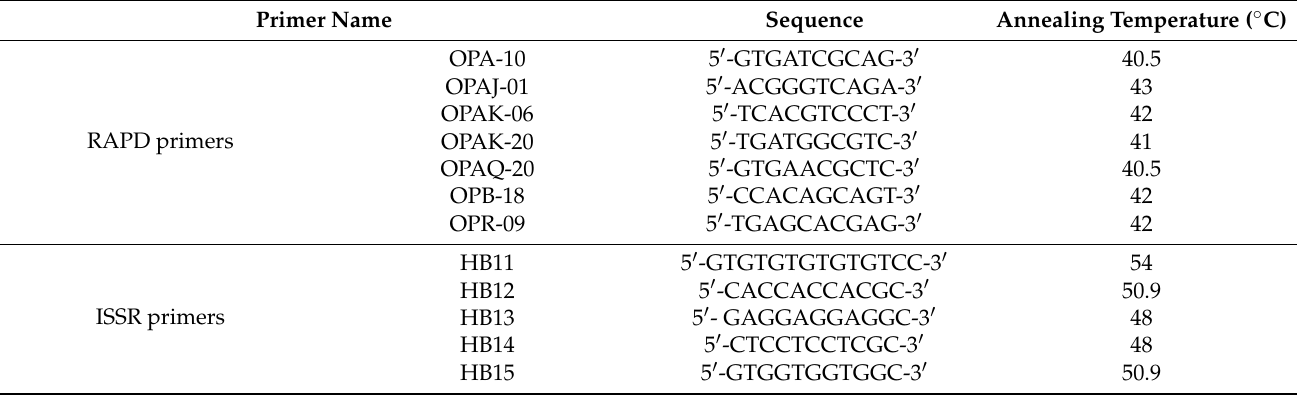
Table 1. Sequences and annealing temperatures of primers used for the RAPD and ISSR analysis of L. schweinfurthii